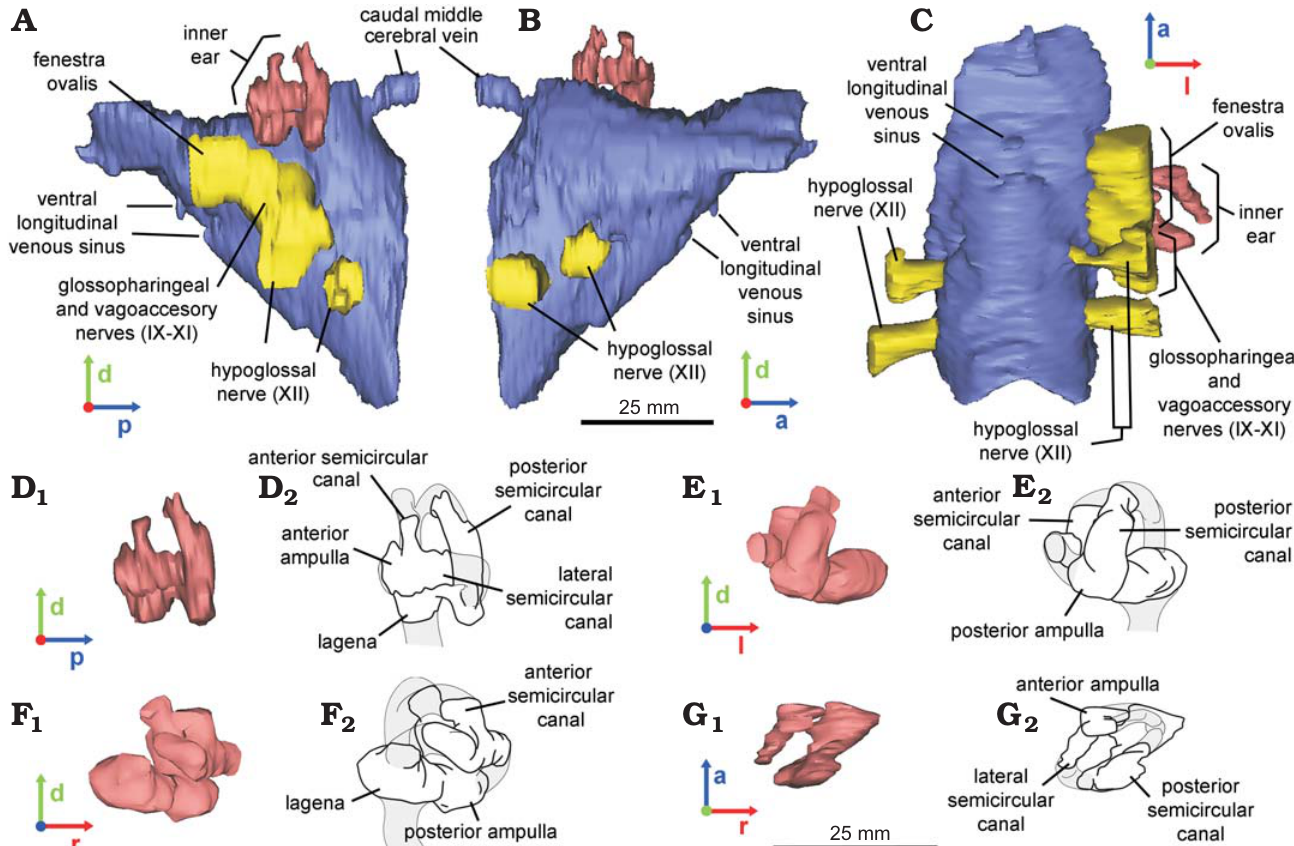
Fig. 4. Reconstructed endocast of braincase (A–C) and inner ear (D–G) of the hadrosaurid dinosaur Secernosaurus koerneri Brett-Surman, 1979 (MACN-RN 02) from the late Campanian–early Maastrichtian, Los Alamitos Formation of North Patagonia; in left ( A , D ), right ( B ), ventral ( C ), poste- rior ( E ), anterior ( F ), and dorsal ( G ) views. Endocasts (A–C, D 1 –G 1 ); line drawings (D 2 –G 2 ). Blue, encephalon; pink, inner ear; yellow, foramina of the cranial nerves. Abbreviations: a, anterior; d, dorsal; l, left; p, posterior; r,